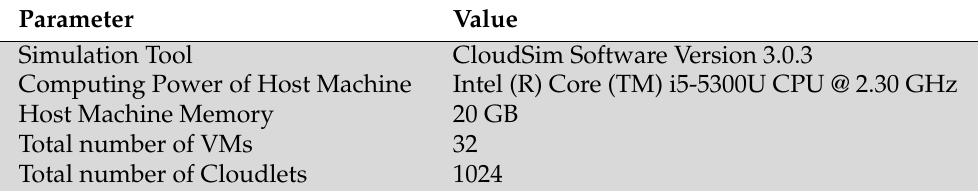
Table 2. Configuration of simulation